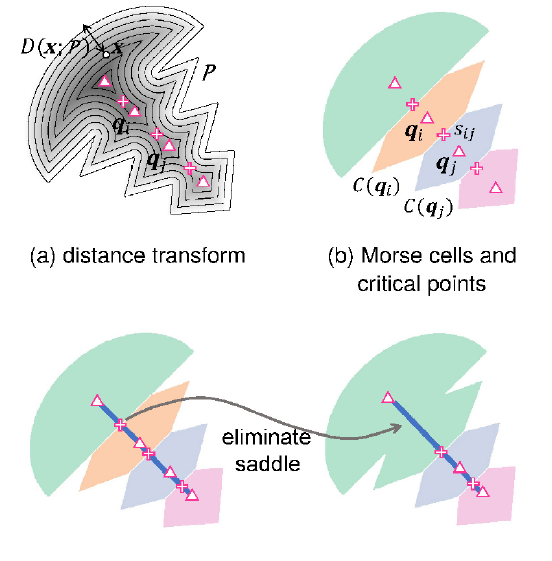
Fig. 3 Generation of the Morse complex and MSG for a simple screw shape. (a) Assume that the input part P is a connected region in the Euclidean space; a distance field is obtained by the distance transform, as illustrated with isocurves. The saddles and local maxima of the distance field are indicated by “+” and “ 4 ” respectively. (b) Each cell of a Morse complex corresponds to a stable manifold centered by a local maximum connected with another cell across a saddle. The MSG is a graph structure defined by these cells. (c) Persistent homology can simplify the complex and the MSG, consecutively removing a saddle and merging